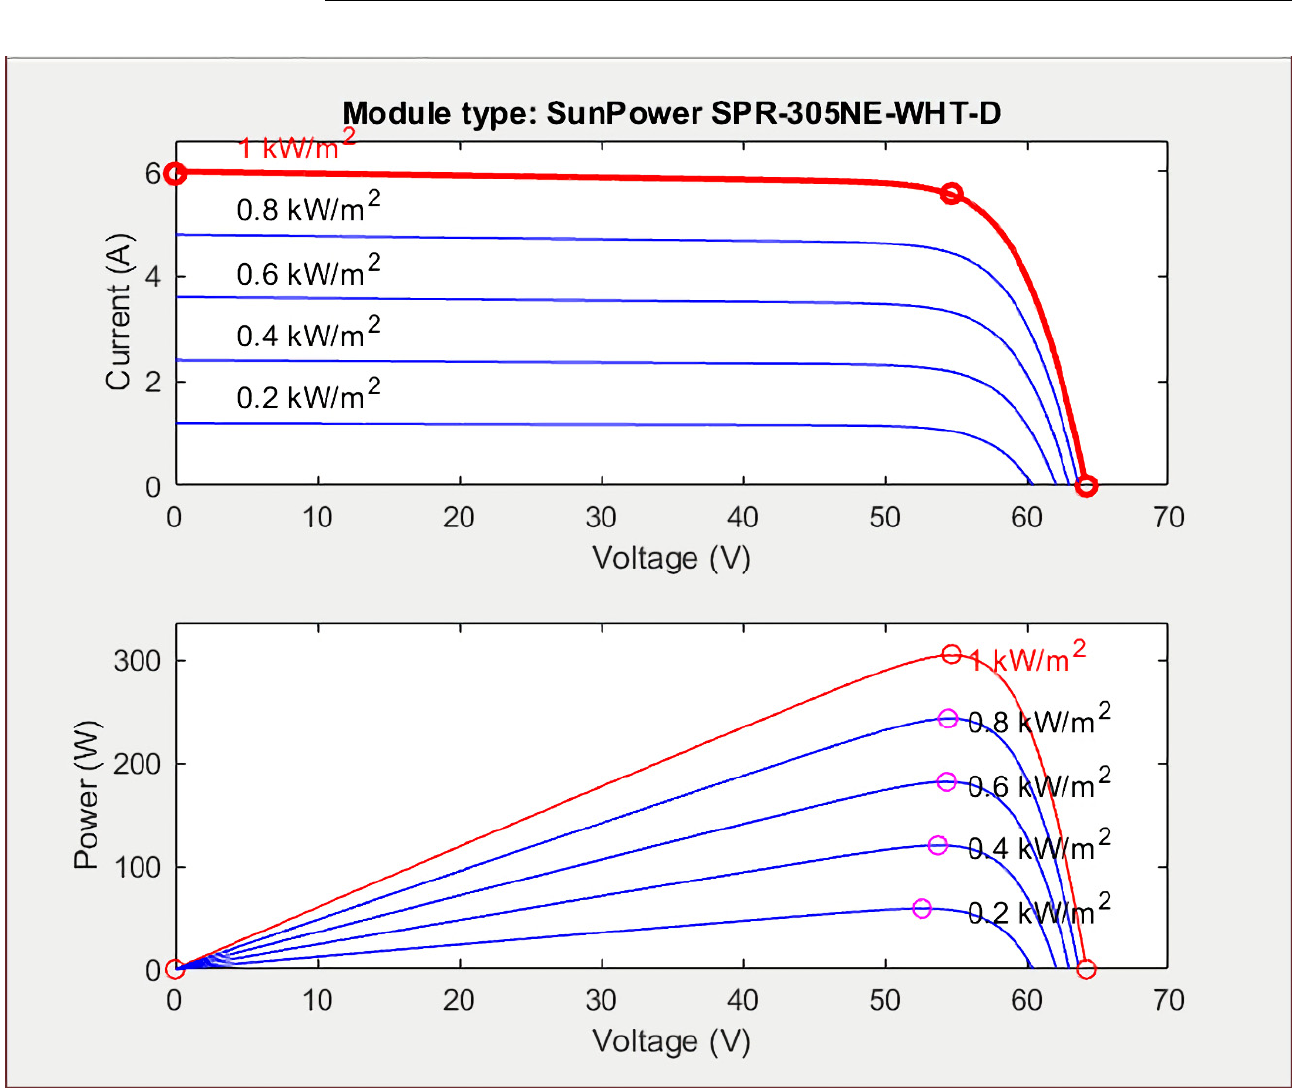
Figure 1. Current–voltage (I–V) and power–voltage (P–V) characteristic curve of a single photovoltaic module under different percentages of shade.